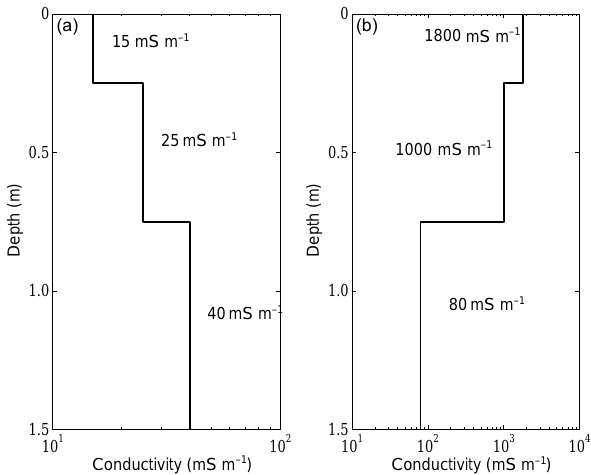
Figure 1. Three-layer synthetic earth model of electrical conductiv- ity for (a) non-saline soil and (b) saline soil in the top